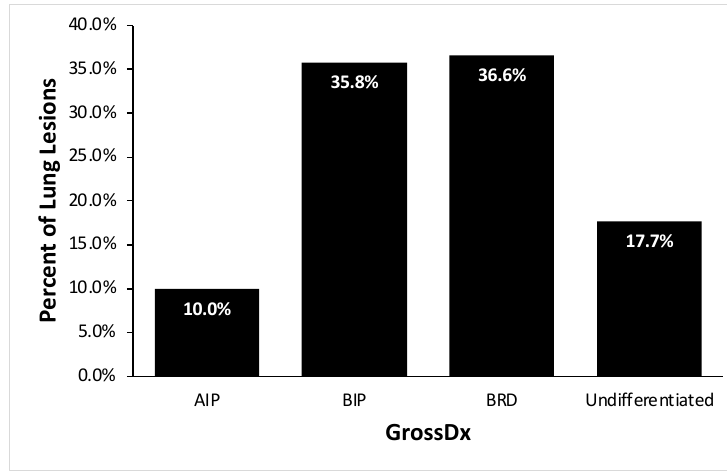
Figure 4. Frequency of pulmonary lesions based on gross diagnosis (GrossDx) for individual cattle ( n = 402) diagnosed with acute interstitial pneumonia (AIP), bronchopneumonia with interstitial pneumonia (BIP), bronchopneumonia (BP), or Undifferentiated (including healthy).